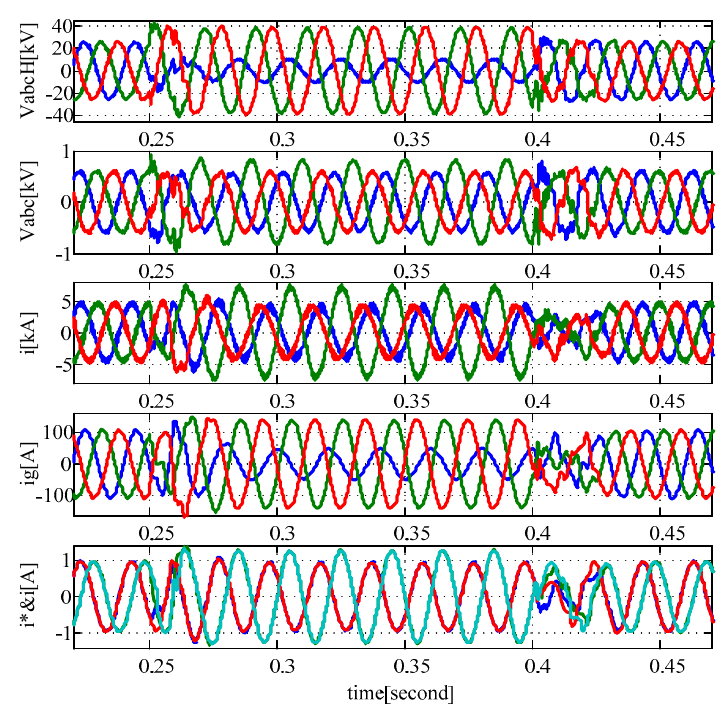
Figure 18. Voltage faults: V ag = 0.5 p.u., V bg = 1.8 p.u., V cg = 1.8 p.u. From top to bottom: in first figure the voltage of grid; in second figure PCC voltage; in third figure converter current; and in fourth figure the current of grid and in fifth figure actual and reference currents in αβ axes.